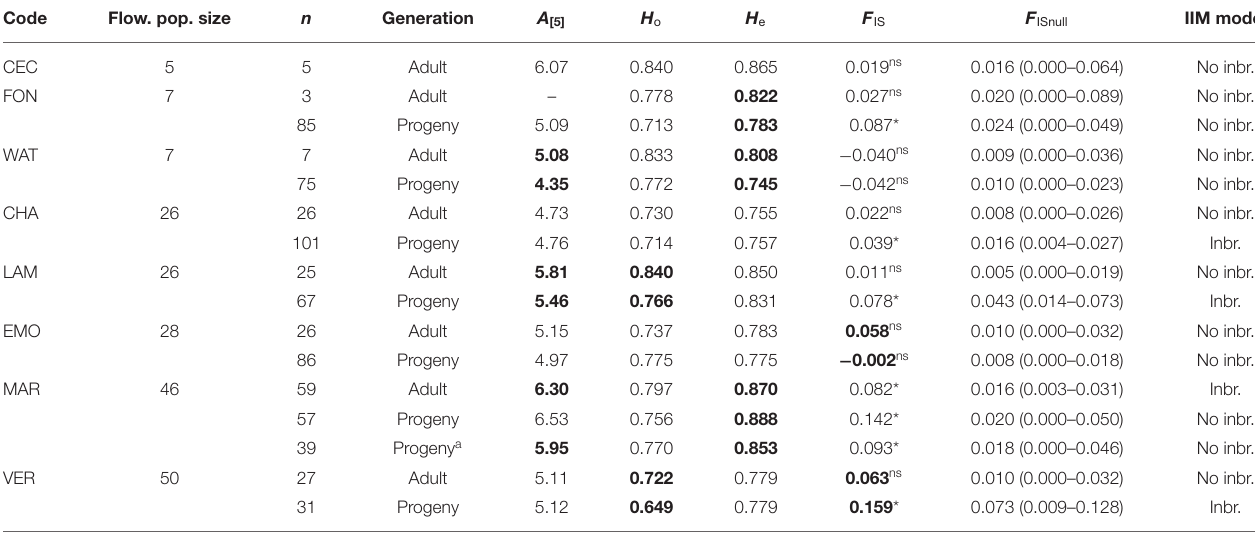
TABLE 2 | Estimates of within-population genetic variation for eight populations of Campanula glomerata at 15 nuclear microsatellite loci. Code Flow. pop.